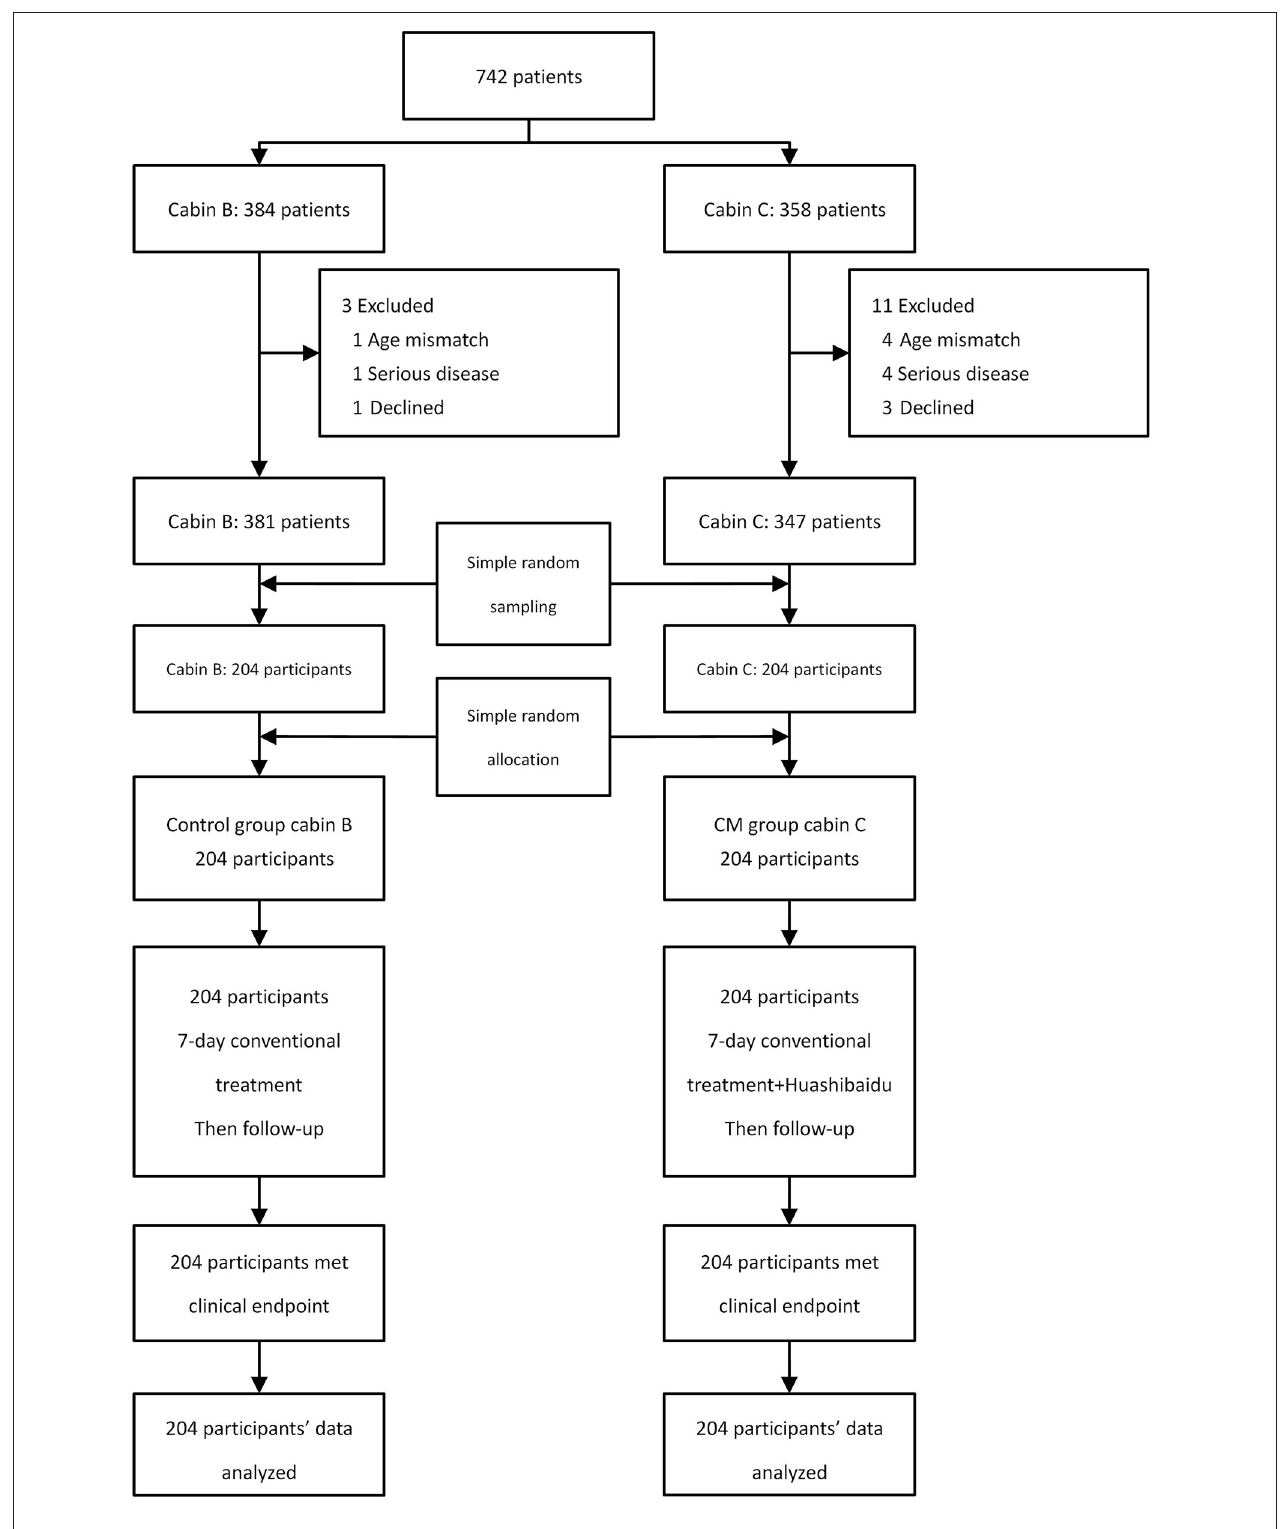
FIGURE 1 | Study flow